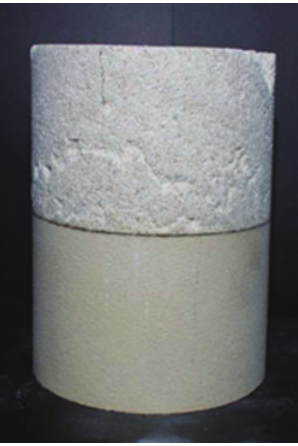
Figure 15 Stress-strain diagrams of the soft Alfopetra and the freshly quarried Kenchreae